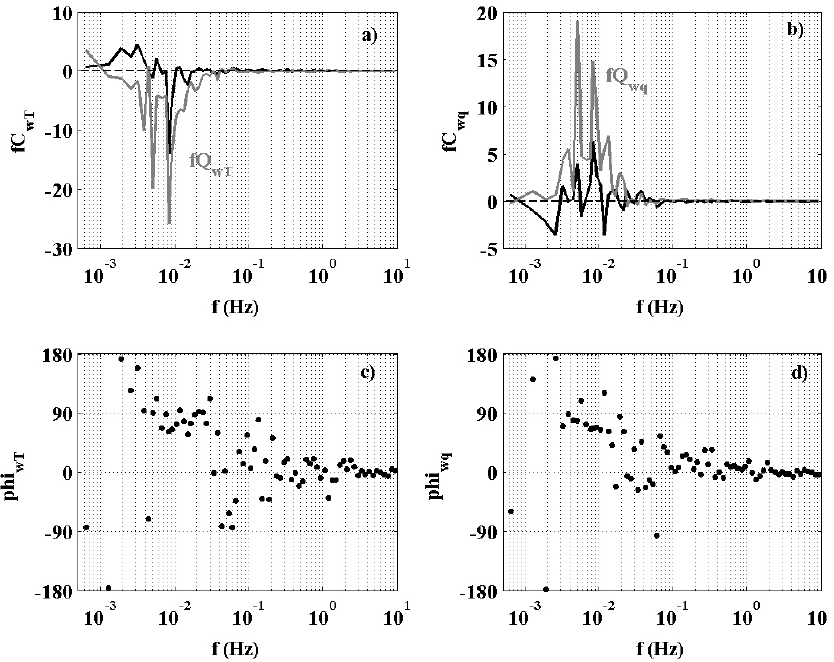
Figure 7. As per Figure 5 but relative to the time series shown in Figure